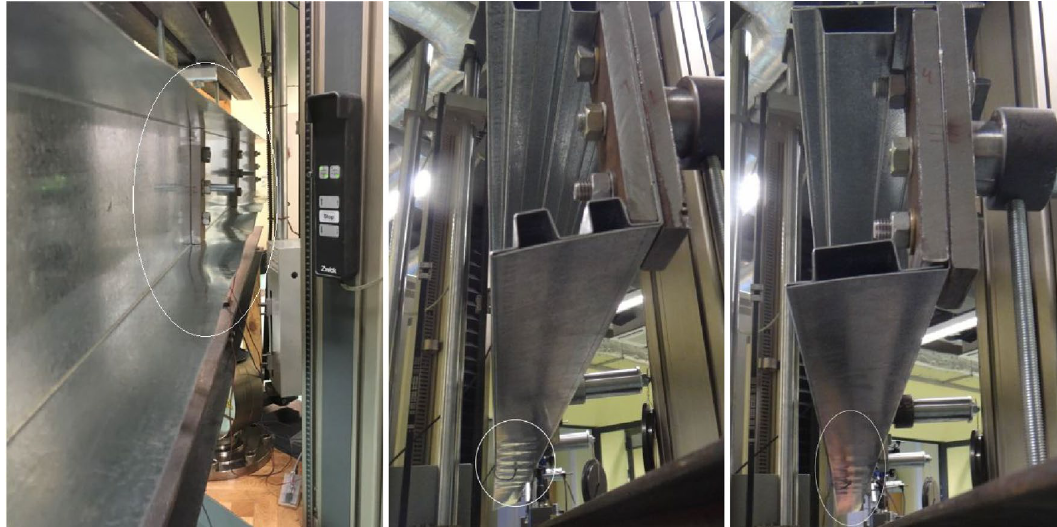
Figure 8. C-Shape no reinforced, double box flange and one box beam after loss of